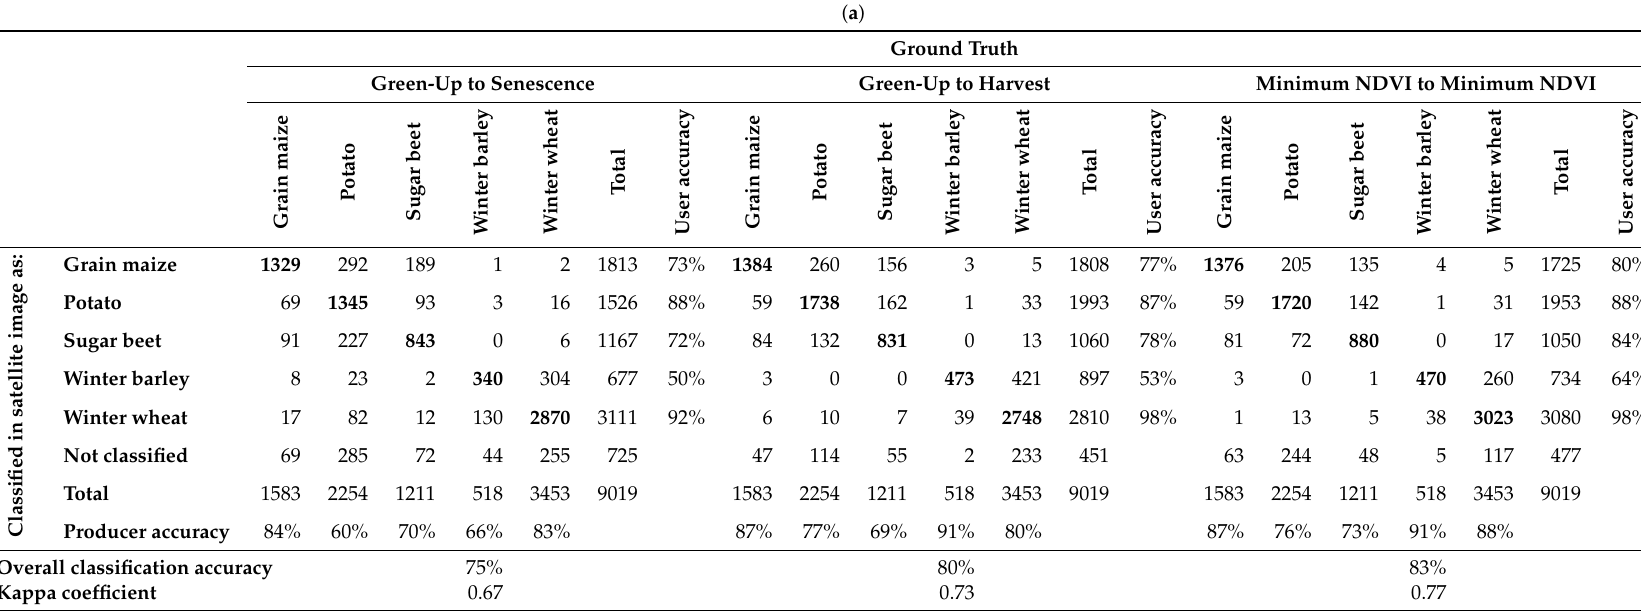
Table 3. Confusion matrix of the post-classification analysis for green-up to senescence, green-up to dormancy and growing season of Flanders-Belgium ( a ), Sria, Russia ( b ), Kyiv, Ukraine ( c ), and Sao Paulo, Brazil ( d ). The number of correctly-classified crops, the producer accuracy, the user accuracy, the overall accuracy and the kappa coefficient are